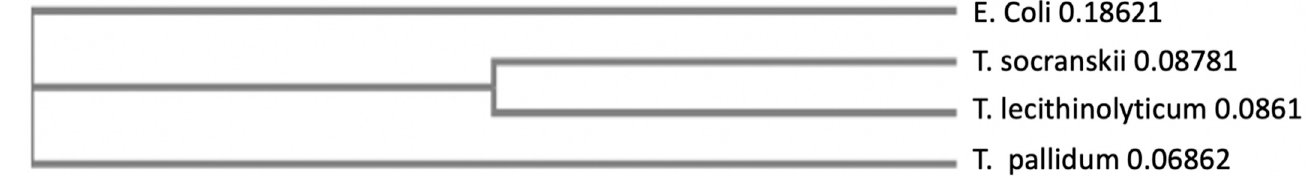
Figure 3. CLUSTAL-OMEGA phylogenetic